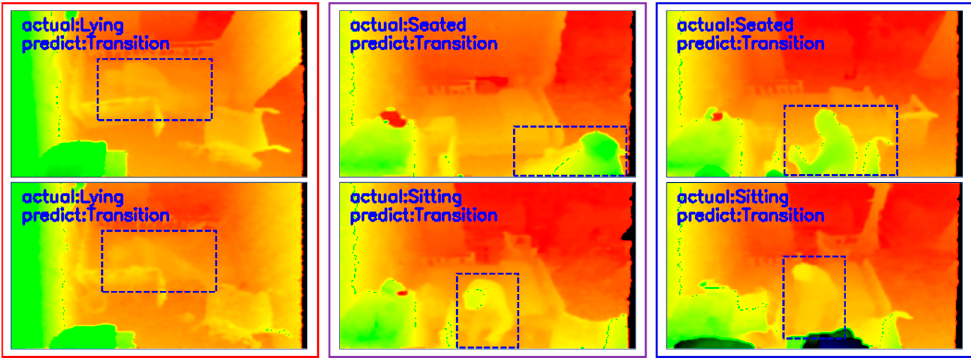
Figure 12. Examples of the common false action recognitions in Situation 1 ( left two images); Situation 2 ( middle two images); and Situation 3 ( right two images).